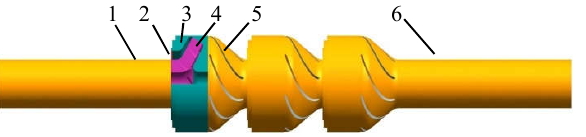
Figure 3. Computation domain. 1. Inlet. 2. End clearance. 3. Cavity. 4. Impeller. 5. Diffuser. 6. Outlet.